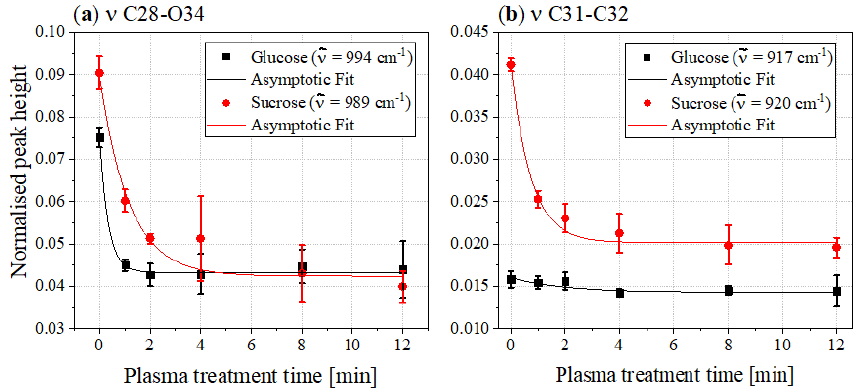
Figure 7. Peak heights of the ( a ) ν CO bands and ( b ) ν CC bands of the FTIR spectra of glucose (black) and sucrose (red) as a function of the plasma treatment time.